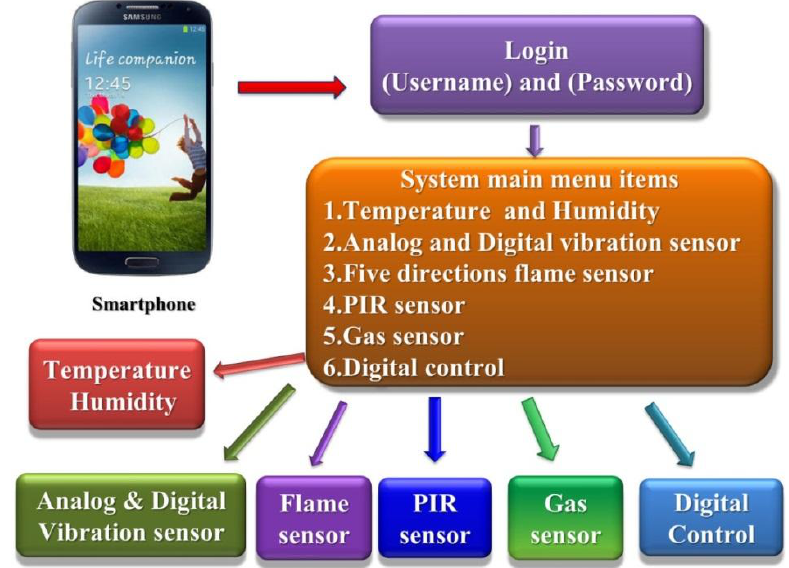
Figure 1. Arduino-based web server